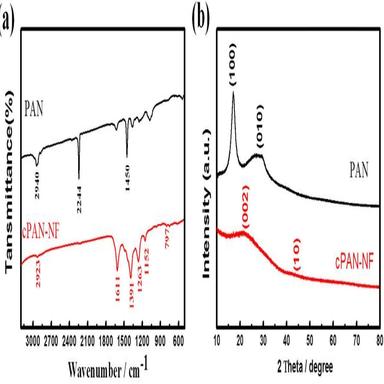
(a) The FT-IR spectra of PAN and cPAN-NF (b) The XRD patterns of PAN and cPAN-NF.